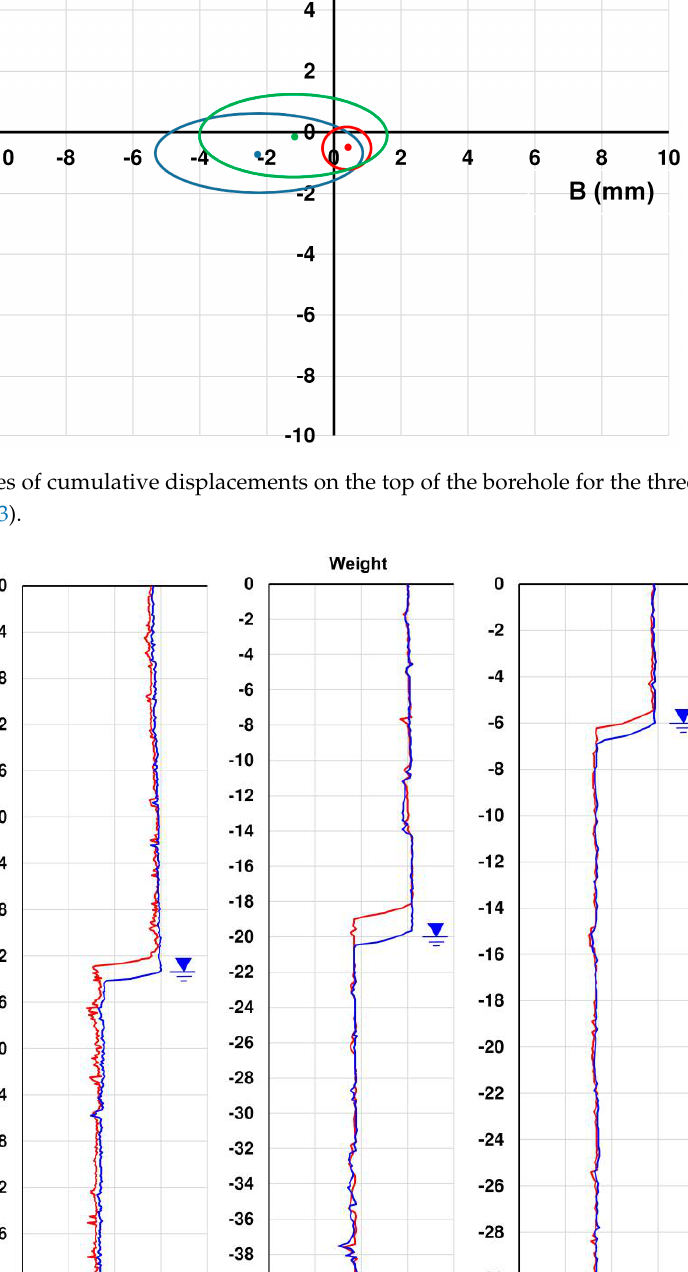
Figure 13. Water level measured into inclinometer tube using the load cell data (in red starting day,